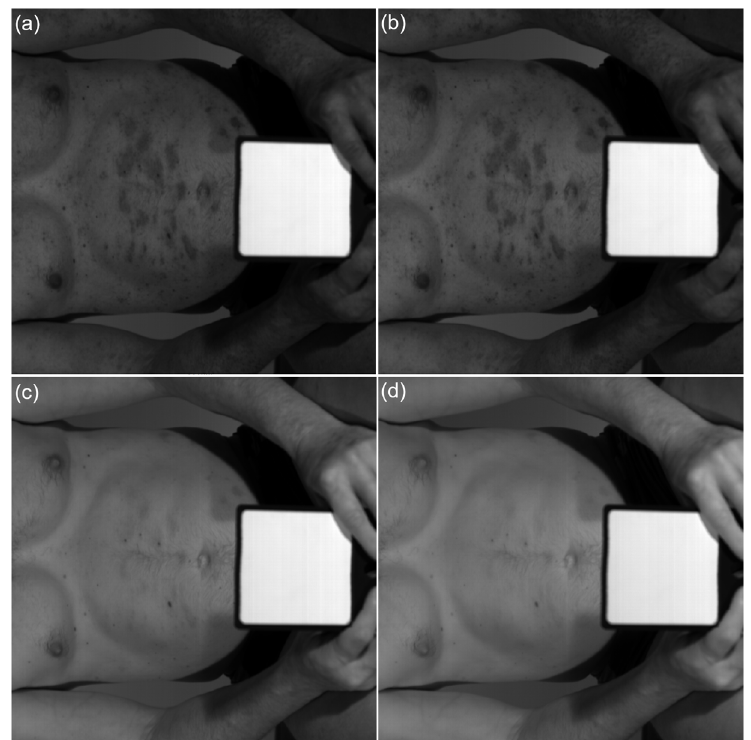
Figure 4. Subchannel images captured by the hyperspectral camera from a psoriatic skin under hal- ogen light illumination: ( a ) 574 nm, ( b ) 596 nm, ( c ) 636 nm, ( d ) 701